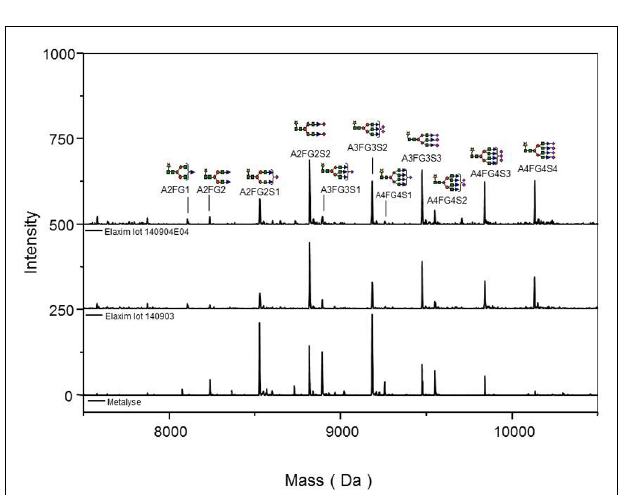
FIGURE 4 | Deconvoluted spectra of glycopeptide 2 (kringle 2) acquired on an ESI-Q-TOF instrument, for Metalyse ® lot #22579 and Elaxim lots #140903 and #140904E04